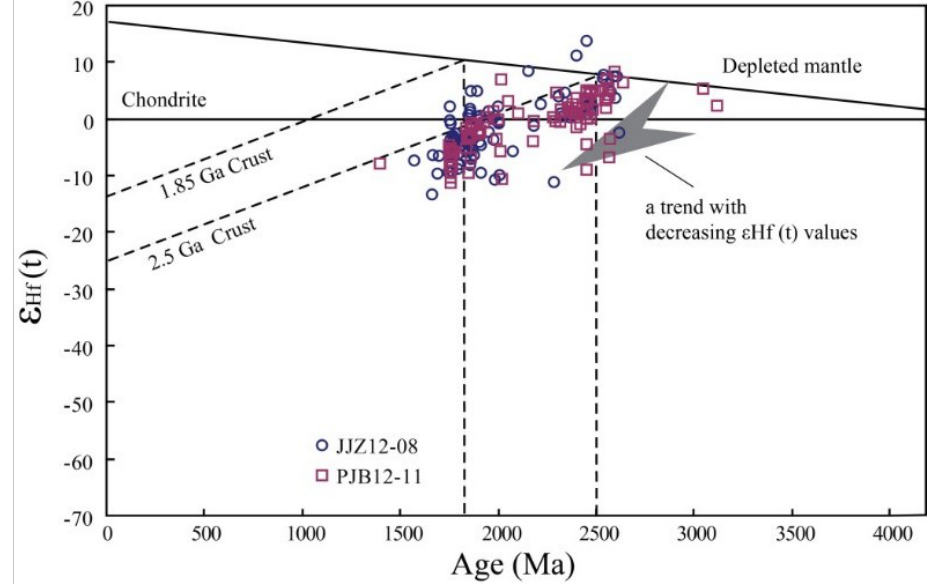
Figure 8. ε Hf ( t ) values versus U-Pb ages of detrital zircon grains from JJZ12-08 and PJB12-11. The dashed lines indicate the evolution trends of average continental crust ( 176 Lu/ 177 Hf = 0.015).